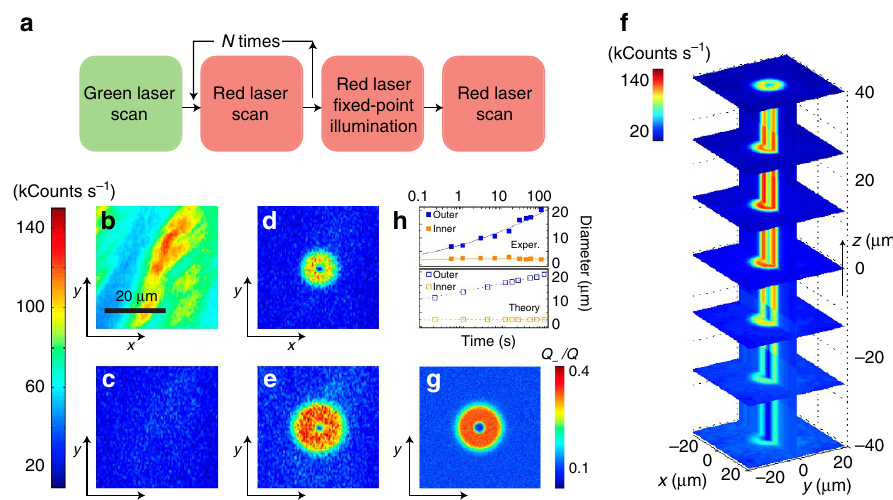
Figure 2 | NV (cid:2) formation during fixed-point, red-light excitation. ( a ) Experimental protocol. A scanning green beam brings a predefined sample area to a well-defined reference configuration. On partially bleaching the sample through repeated red beam scanning, the red laser is focused on an arbitrary (but fixed) point for a time t R . Finally, a fluorescence image is acquired via a readout scan. ( b ) Reference fluorescence image as obtained immediately after the green laser reset scan; the green beam power is 0.4mW. ( c ) Fluorescence image after N ¼ 5 red laser bleach scans and in the absence of fixed-point illumination. ( d , e ) Fluorescence image after prolonged red excitation at the centre point of the scanned area. The red laser power is 2.0mW during bleaching and fixed-point excitation, and 0.1mW during scanning; the fixed-point excitation times are 15s in d and 60s in e . ( f ) 3D reconstruction of the NV (cid:2) pattern resulting from 25s of red, fixed-point excitation. All other conditions as in d and e . ( g ) Numerical calculation of the map in e as determined from equations (1–4) for 60s red illumination (see e for comparison). ( h ) Time evolution of the outer and inner diameters of the observed (upper half graph) and calculated (lower half graph) bright ‘torus’. Filled (empty) squares are experimental (calculated) data points; solid (dashed) lines serve only as a guide to the eye. In all scanned images the size is 100 (cid:5) 100 pixels and the integration time per pixel is 1ms. The scale bar in b applies to all images. See Supplementary Table 1 for a summary on the simulation